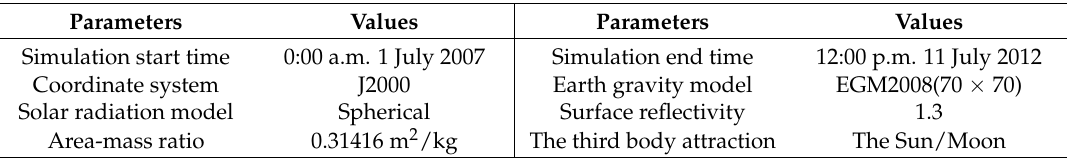
Table 6 . STK parameters and options for the perturbations’ simulation. Table 6. STK parameters and options for the perturbations’ simulation.